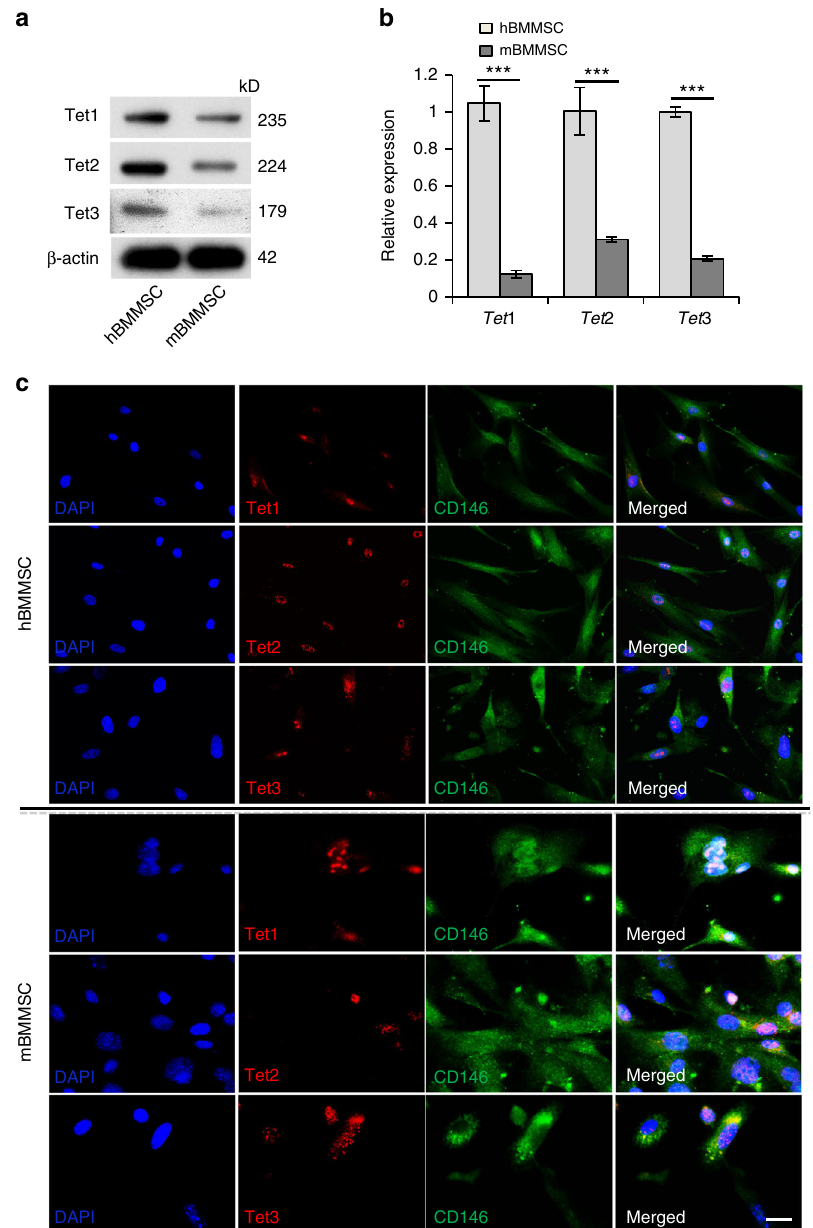
Fig. 1 BMMSCs express Tet1, Tet2, and Tet3. a , b Both human (h) and mouse (m) BMMSCs expressed Tet1, Tet2, and Tet3, as assessed by western blotting ( a ) and qPCR ( b ). c Immunocyto fl uorescent staining showed that CD146-positive BMMSCs expressed Tet1, Tet2, and Tet3. Scale bar, 50 μ m. Results are from three independent experiments. *** p <0.001; p values calculated using two-tailed Student's t test (mean ± indicated by Oil Red O staining and the expression of adipogenic- related genes lipoprotein ( LPL ) and peroxisome proliferator- activated receptor γ 2 ( PPAR γ 2 ) (Supplementary Fig. 2d, e). These data indicate that Tet1 and Tet2 depletion impaired BMMSC function.